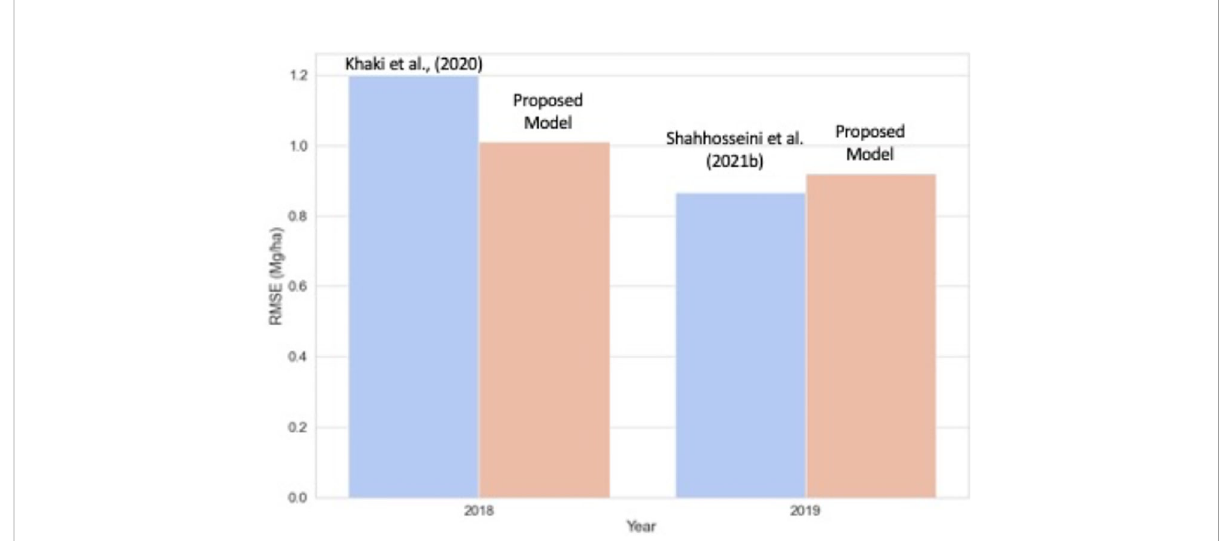
FIGURE 9 Comparison of the proposed model with state-of-art corn yield prediction model for the US Corn Belt. For 2018, the proposed model is compared against Khaki et al. (2020), and for the year 2019, the model is with Shahhosseini et al.